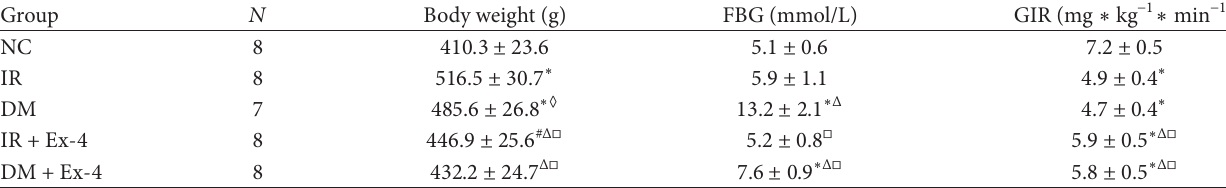
Table 1: Body weight, FBG, and insulin sensitivity of rats at the end of the study (mean ± SE).